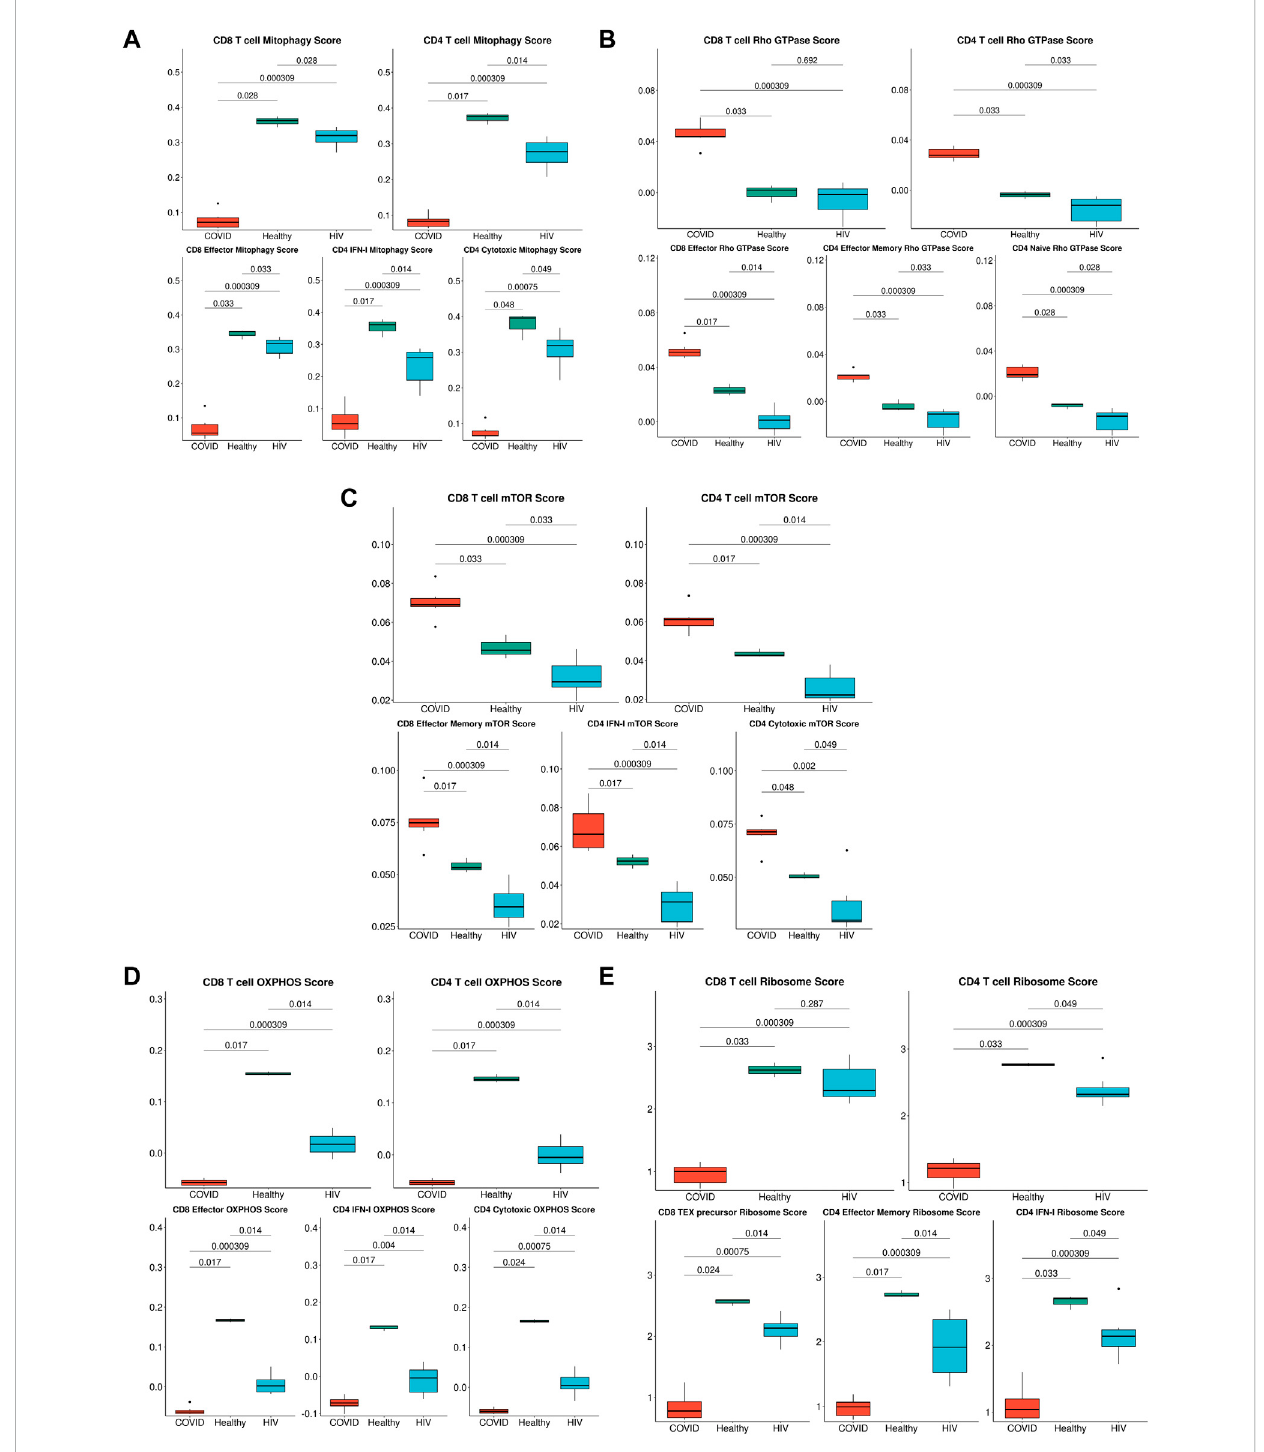
FIGURE 7 Metabolic differences associated with HIV-1 and COVID-19. (A) Box plots of the average expression of the mitophagy signature score in CD8 + and CD4 + T cells across each disease condition (top), Box plots of the average expression of CD8 + effector, CD4 + IFN-I and CD4 + cytotoxic mitophagy signature score for each disease condition (bottom). p -values are computed with Wilcoxon signed-rank test with Holm-Bonferroni adjustment. (B) Box plots of the average expression of the Rho GTPase signature score in CD8 + and CD4 + T cells across each disease condition (top), Box plots of the average expressionofCD8 + effector,CD4 + effector memory,and CD4 + naïve Rho GTPase signature score for each disease condition (bottom). p -values arecomputedwithWilcoxonsigned-ranktestwithHolm-Bonferroniadjustment. (C) BoxplotsoftheaverageexpressionofthemTORscoreinCD8 + and CD4 + T cells across each disease condition (top), Box plots of the average expression of CD8 + effector memory, CD4 + IFN-I, and CD4 + cytotoxic mTOR signature score for each disease condition (bottom). p -values are computed with Wilcoxon signed-rank test with Holm-Bonferroni adjustment. (D)